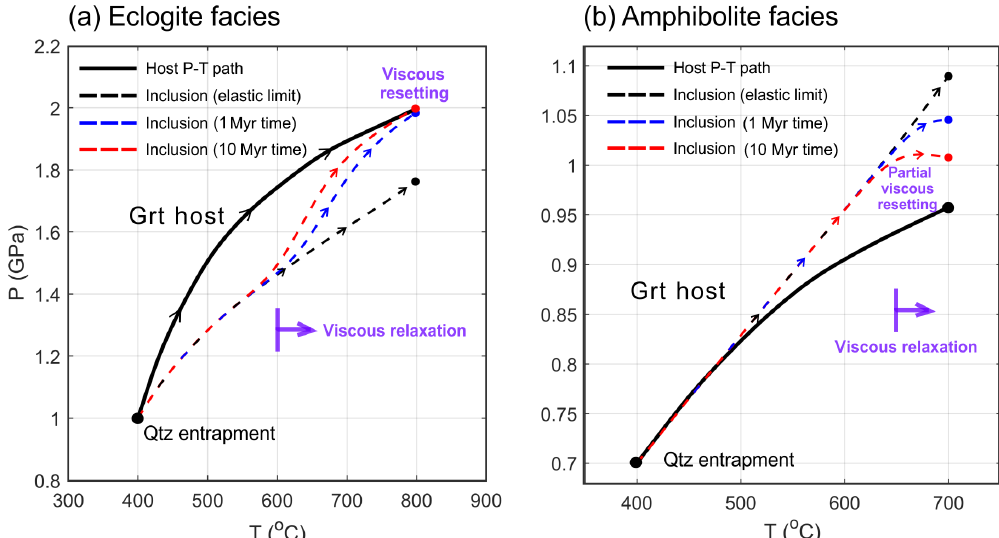
Figure 5. The prograde P – T path for inclusion (dashed curve) and host (solid curve). Panel (a) is for rocks that experienced eclogite- facies peak P – T conditions. The quartz inclusion is entrapped at 400 ◦ C and 1GPa. Along the given prograde P – T path, viscous relaxation becomes significant at >600 ◦ C. The duration of the prograde P – T path is illustrated with different colours (1 and 10Myr; see legend). At 800 ◦ C, the quartz inclusion pressure is reset to the confining pressure (host). For rocks that experienced amphibolite-facies peak P – T conditions (b) , viscous relaxation becomes significant at ca. 650–700 ◦ C and the quartz inclusion pressure is partially reset at 700 ◦ C. Pure almandine garnet is used as a host, and its flow law is from Wang and Ji (1999).